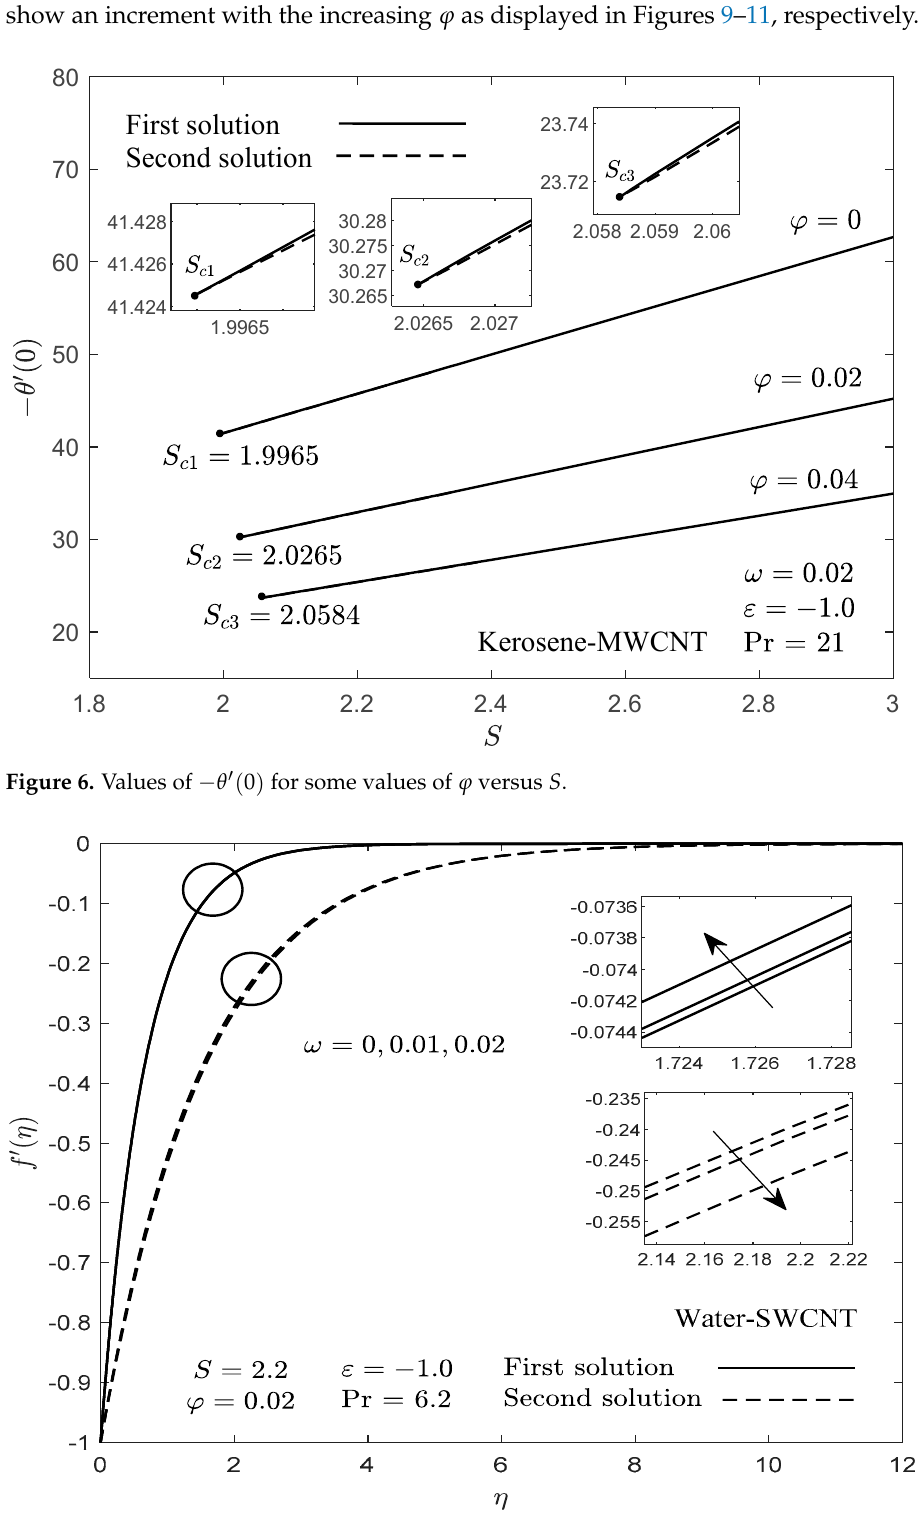
Figure 7. Velocity profiles of 𝑥 -component 𝑓′(𝜂) for some values of 𝜔 . The presence of more suspended particles in the flow decelerates the velocity of x - component because the surface is only compressed in the x -direction. Since the